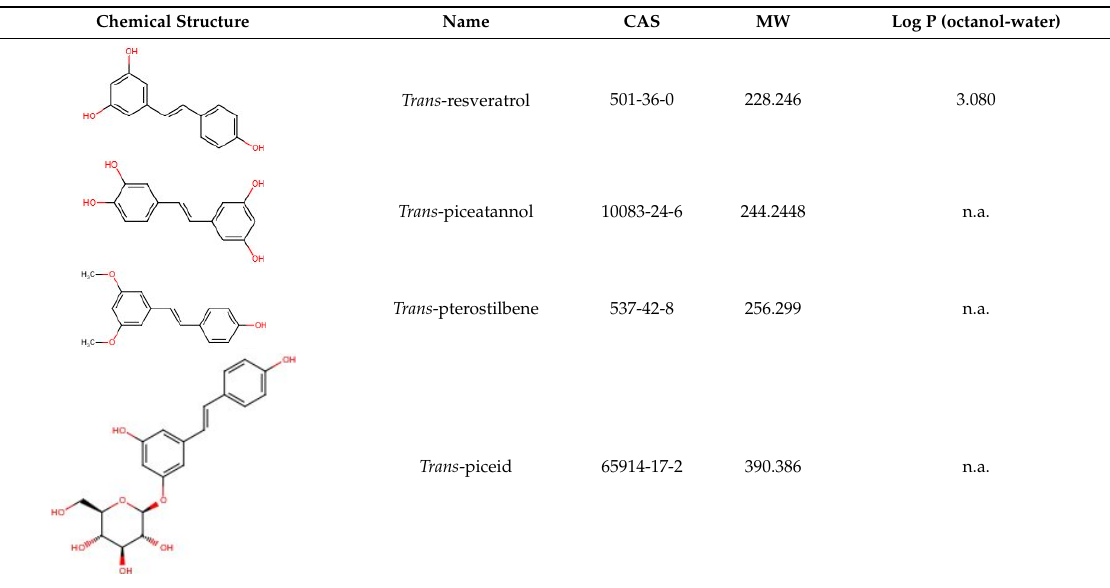
Table 5. Chemical structures name of the analytes studied. Table 5 Chemical structures name of the analytes